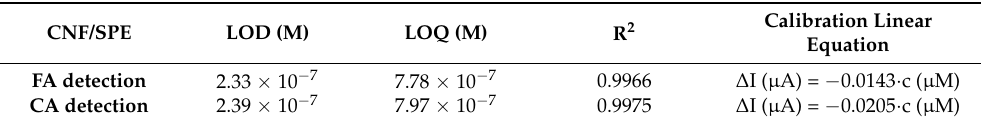
Table 3. Comparison of different methods to determine CA and FA.